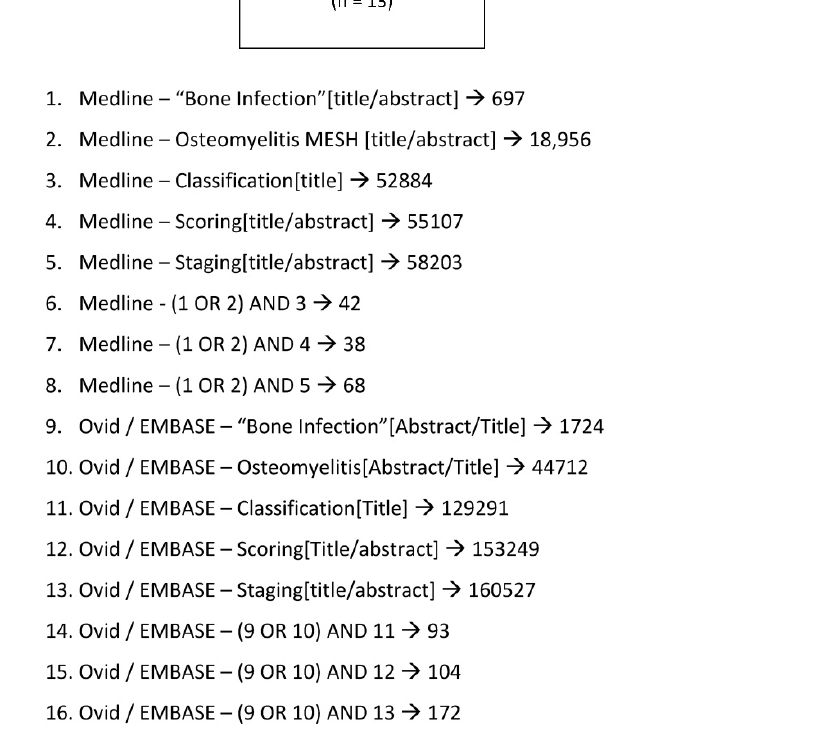
Figure 1 . PRISMA 2009 Flow